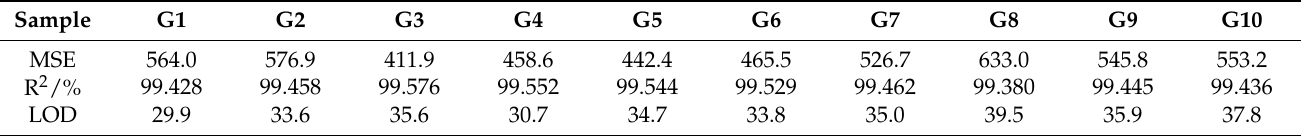
Figure 15. Evaluation of the effectiveness of the KPBP-optimized internal standard model by creating 10 calibration curves with only 20 spectra from each sample. All 10 curves are plotted in the same coordinate system ( left ). The calibration curve of G1 is presented with error bars and relative prediction errors as an example ( right ). Table 3. The model performance of the 10 calibration curves (unit ppm unless noted).